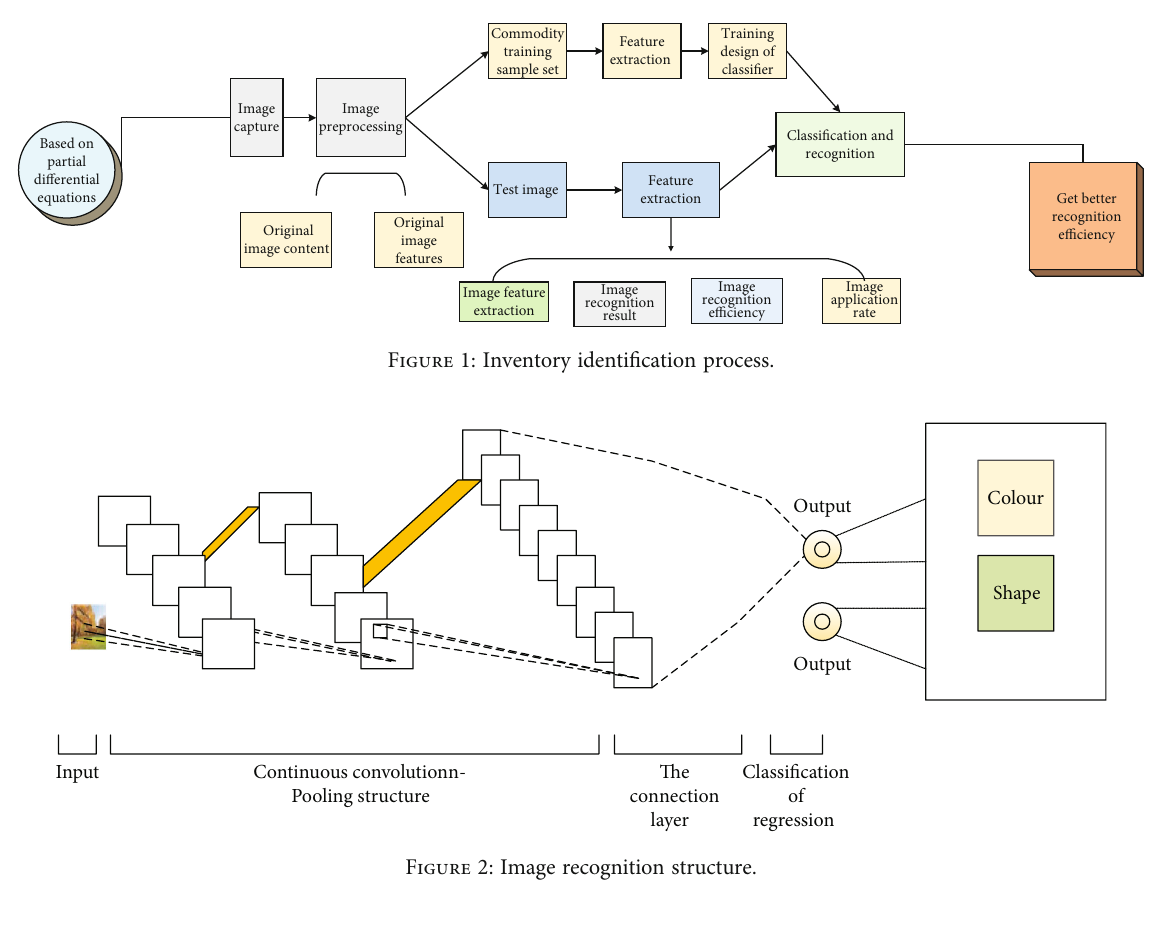
Table 1: Average distance method and error correction SVM identi fi cation results based on PCA features with di ff erent feature dimensions (in